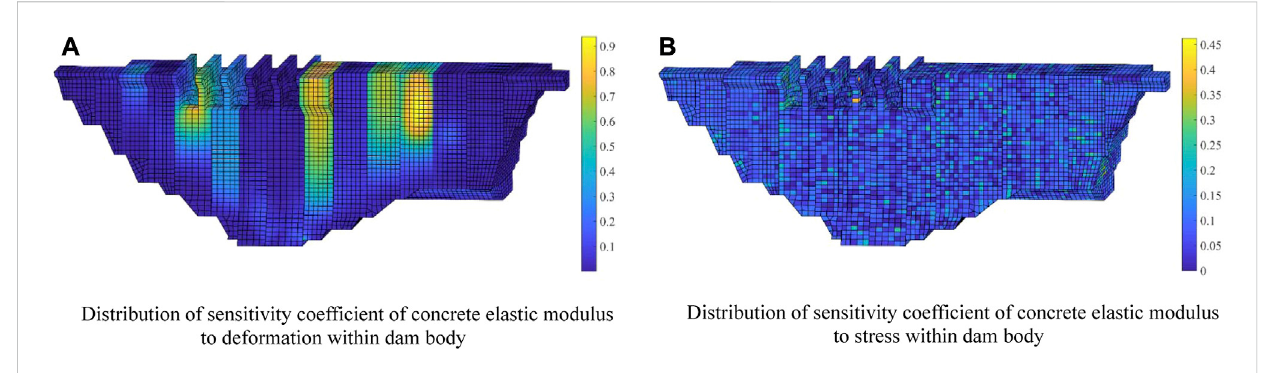
FIGURE 6 The sensitivity distribution of a particular parameter to static